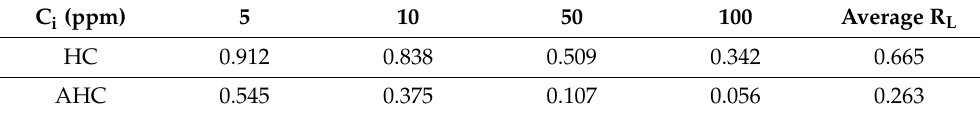
Table 2. Separation factors (R L ) for HC and AHC samples at different initial concentrations of MB dye. C i